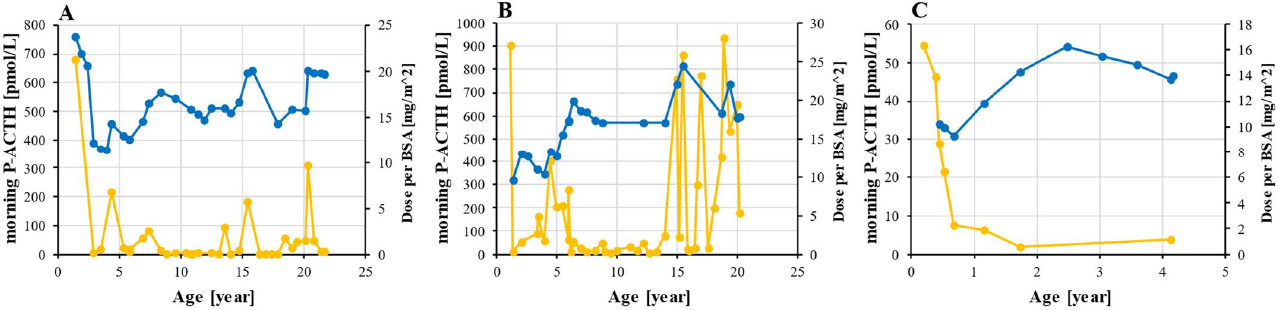
Figure 4. Hydrocortisone dosing and ACTH monitoring. ACTH (orange) was measured from morning plasma sample and hydrocortisone dose (blue) was adjusted to BSA in patient 1 ( A ), 2 ( B ), and 3 ( C ). Abbreviations: ACTH—corticotropin; BSA—body surface area; P—plasma.